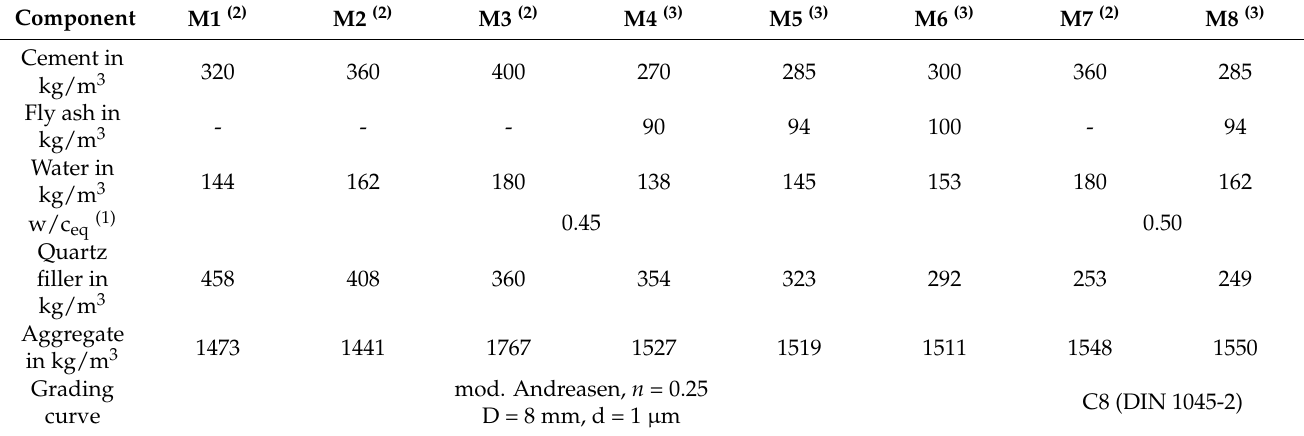
Table 3. Composition of the concrete mixtures (assumed air content: 2